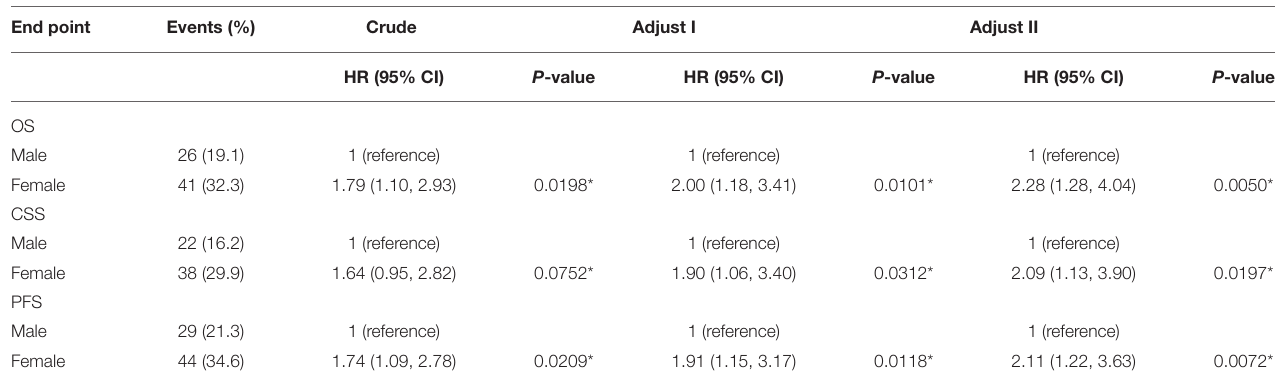
TABLE 5 | Survival after radical surgery: multivariable analysis comparing female with male